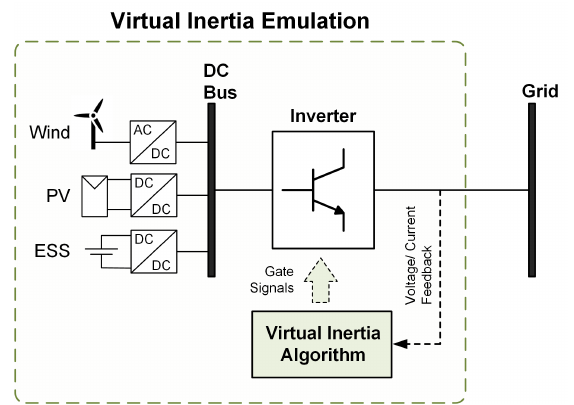
Figure 5. Concept of virtual inertia.